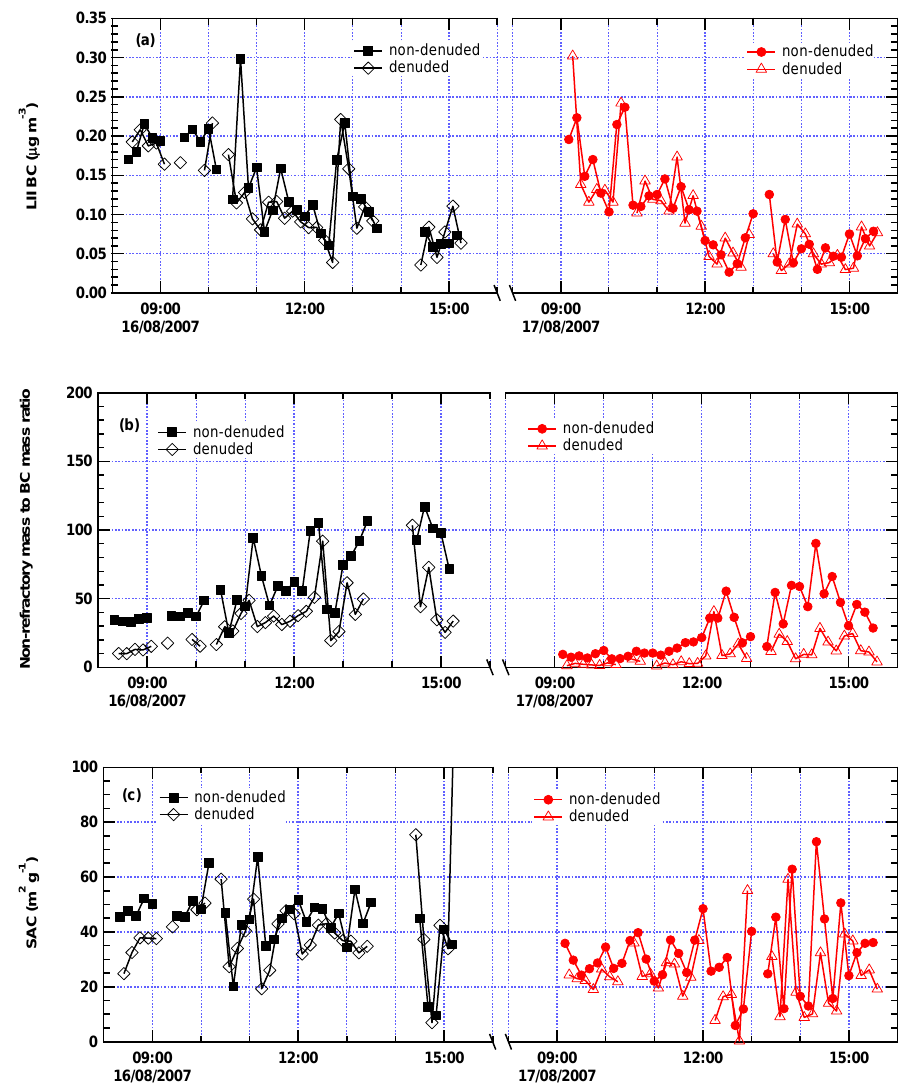
1341 Fig. 3. Time series of (a) black carbon mass concentration, (b) non-refractory mass to BC mass ratio, (c) specific absorption cross-section, (d) organic matter mass concentration, (e) sulphate mass concentration, (f) nitrate mass concentration, and (f) PPS during the two days